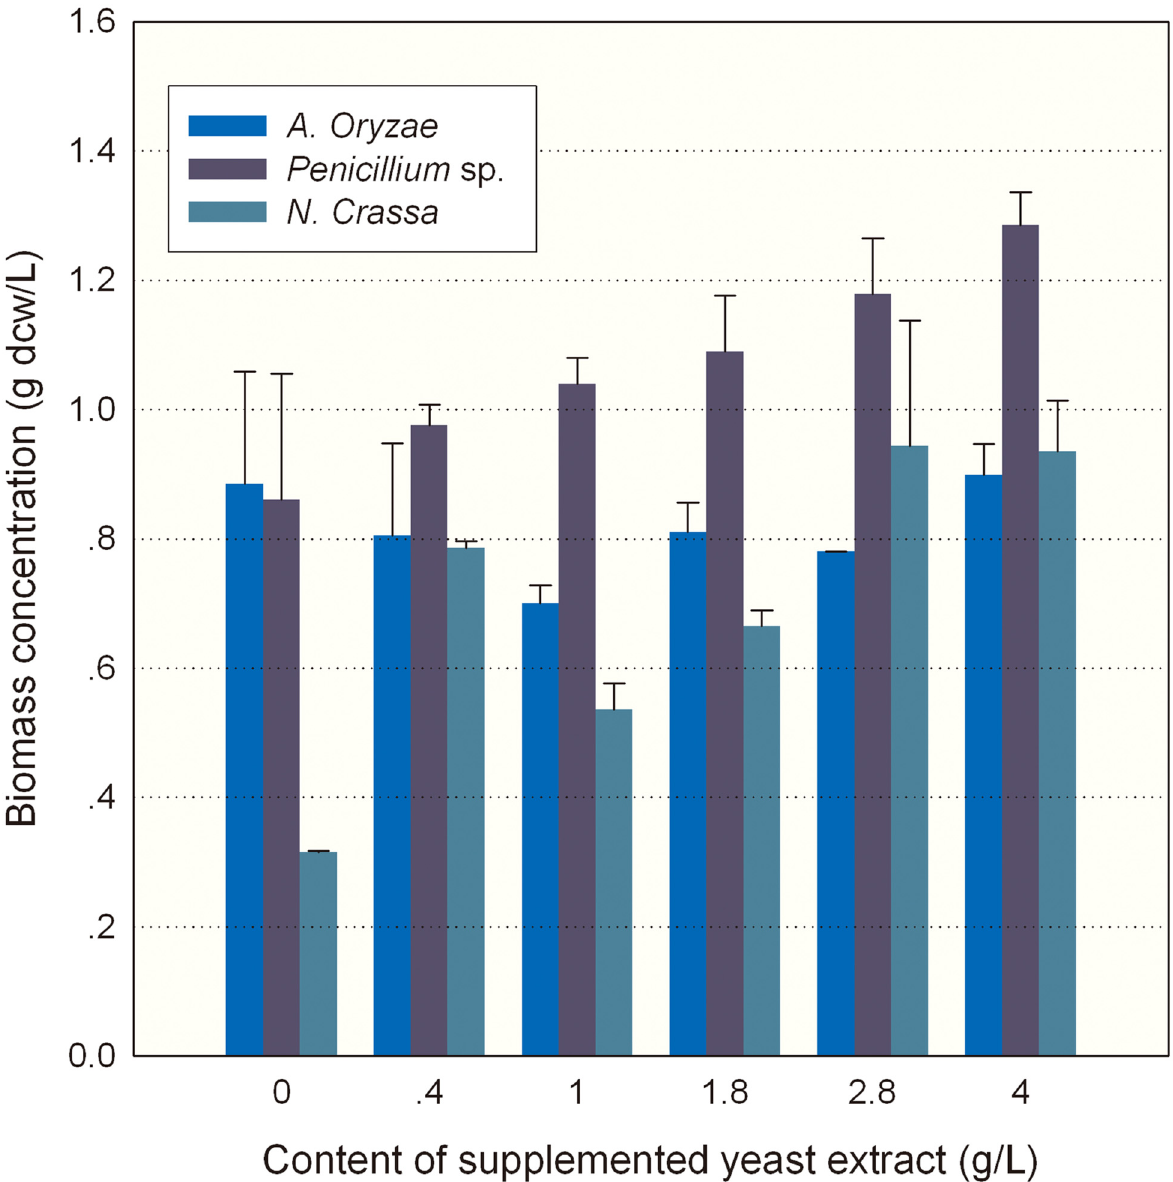
Fig 5. Biomass concentration of C . cohnii grown on RMH supplemented with yeast extract. The meal hydrolysates produced by individual fungal stains were supplemented with different levels of yeast extract. Data of biomass concentration are means of three replicates, and error bars show standard